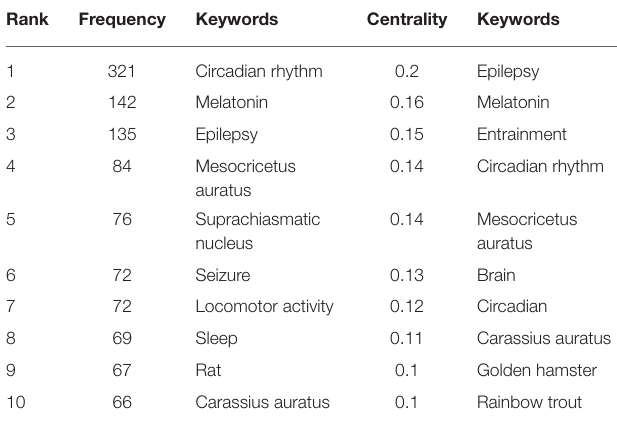
TABLE 4 | Top 10 keywords in terms of frequency and centrality of epilepsy and circadian rhythm. Rank